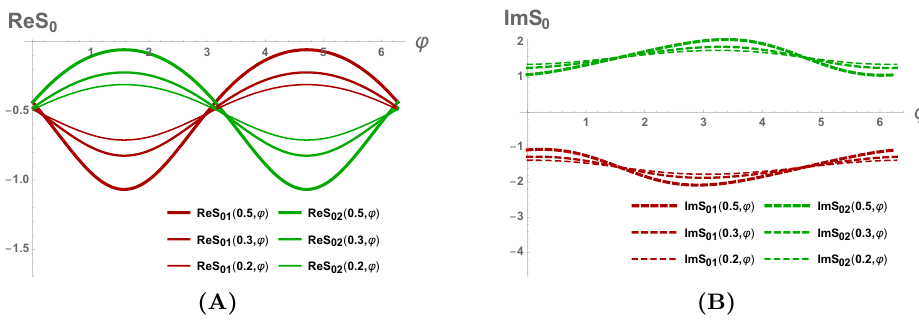
Figure 1 . Plots of real ( A ) and imaginary ( B ) parts of the actions on the stationary point, S 0 ;i ( a; ’ ) for J = 1, di(cid:11)erent a < 2 and 0 < ’ < 2 (cid:25) . i = 1 ; 2 corresponds to the (cid:12)rst and second stationary points and are presented by red and green color, respectively.